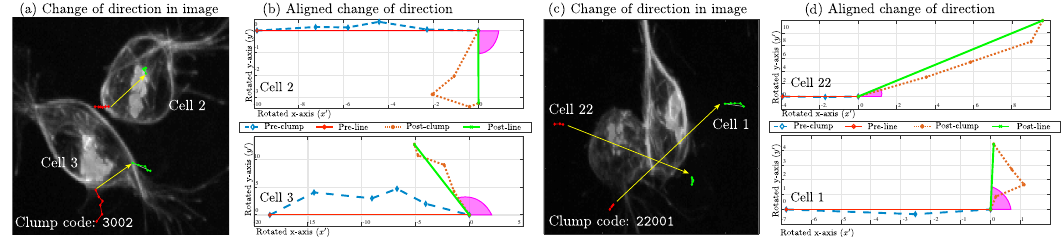
Figure 10. Examples of change of direction before and after a clump . Two examples of cells interacting in three different clumps : 3002 ( a , b ) and 22001 ( c , d ). ( a , c ) Red line ( ∗− ) shows the orientation of movement before the clump , and a green line (. − ) represents the positions of movement after. A yellow arrow was superimposed on the image to show the trajectory of the cell inside the clump . ( b , d ) Simplified view of the cells’ changes in orientation. The cells’ path before the clump is represented in blue ( − · − ). The path of the cell after the clump is shown in orange (: ∗ ). The angle arc of orientation is shown in